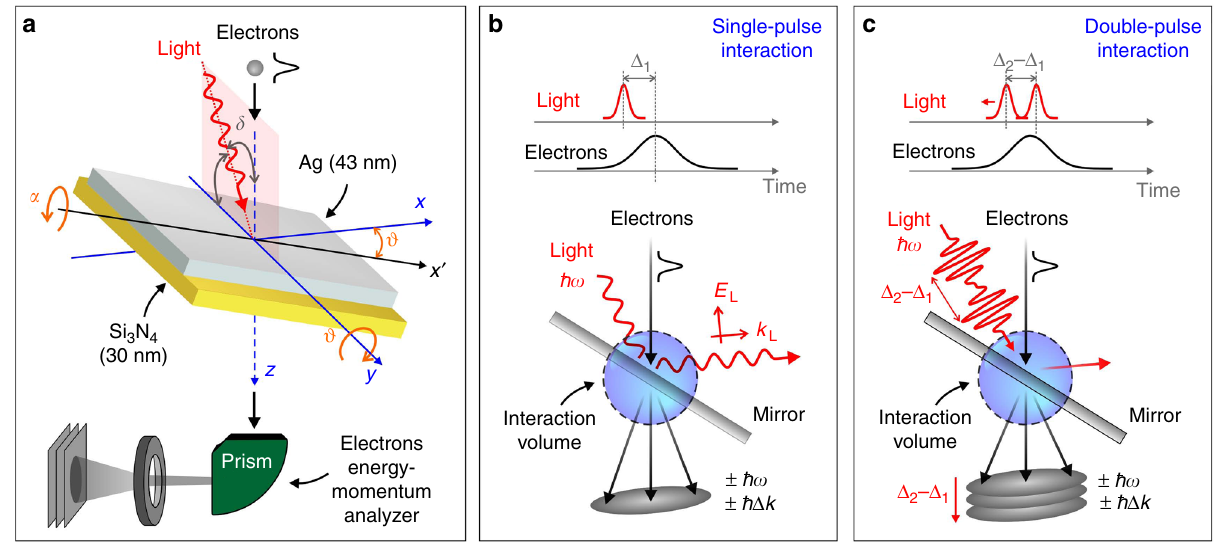
Fig. 1 Experiment probing free-electron interaction with semi-in fi nite light fi elds. a Ultrashort 200 keV electron pulses travel along the z axis and impinge on the surface of a Ag/Si 3 N 4 thin bilayer, which is mounted on a double-tilt holder able to rotate around the x (angle α ) and y (tilt angle ϑ ) axes. Light propagates within the y – z plane, incident with an angle δ ~ 4 – 5° relative to the z axis and then re fl ected from the Ag surface. The resulting electron – photon interaction is probed by monitoring electron energy-loss spectra as a function of geometrical parameters and light properties. b Description of the electron – light interaction here explored. The breaking of translational invariance produced by light re fl ection enables photon absorption or emission by the electron corresponding to a quantized energy and momentum exchange. c Description of the three-pulse experiment used for coherent modulation of the electron wave function. Electrons interact with an appropriately synthesized optical fi eld distribution produced by two mutually phase-locked photon pulses whose relative phase is changed by varying their relative delay Δ 2 − Δ